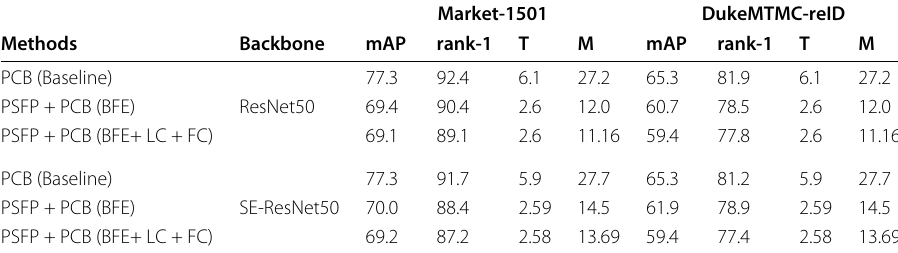
Table 8 Comparison of network accuracy (mAP and rank-1) and complexity (M: Parameters and T: GFLOPS) with different pruning scenarios on all the person ReID datasets. BFE backbone feature extractor; LC, local convolutional layer; FC, fully connected layer Market-1501 DukeMTMC-reID Methods